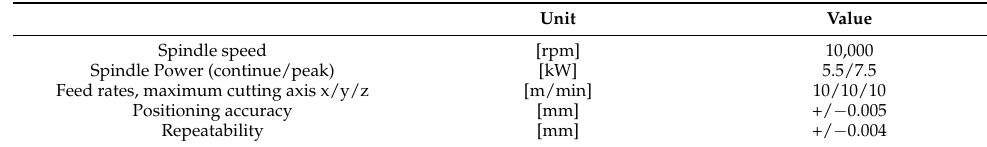
Table 2. Challenger 2418 CNC machine